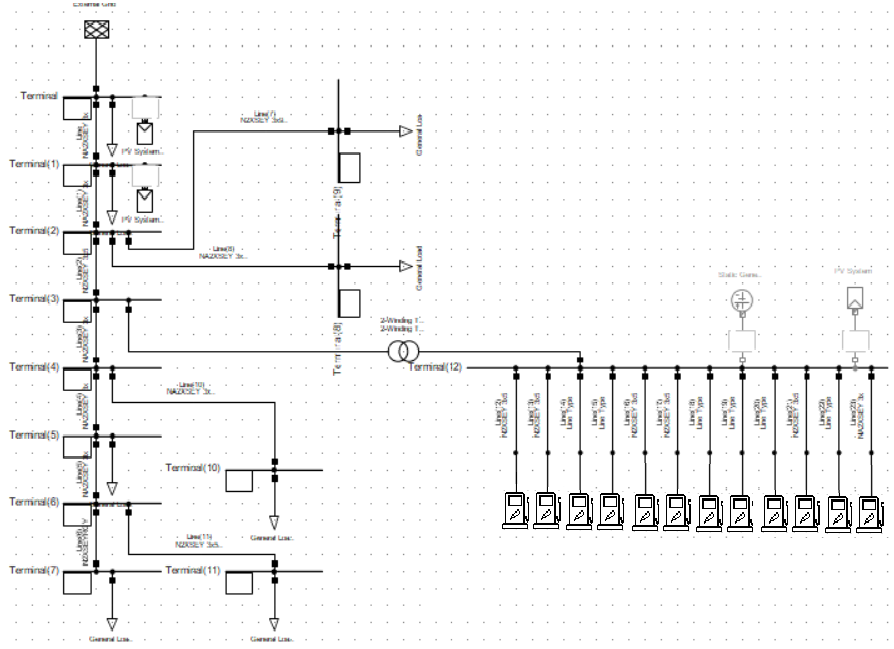
Figure 12. 15 kV rural distribution network.